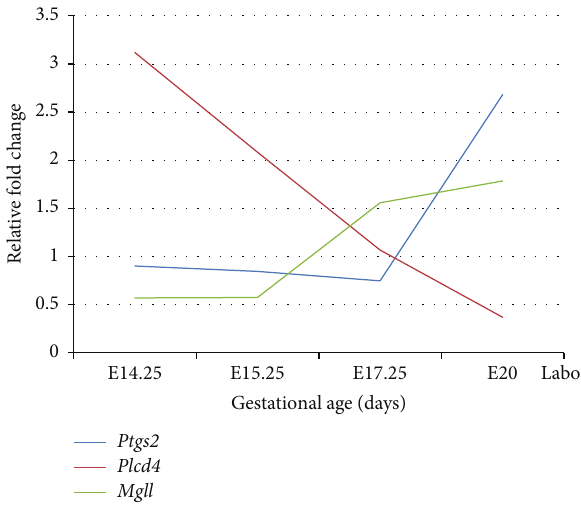
Figure 4: Proposed relationship of the 3 differentially expressed genes Ptgs2, Plcd4, and Mgll from mid to late gestation from qPCR